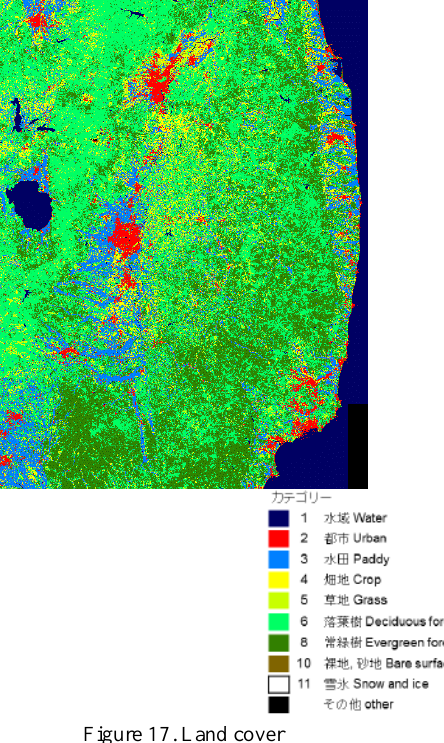
Figure 17. Land cover